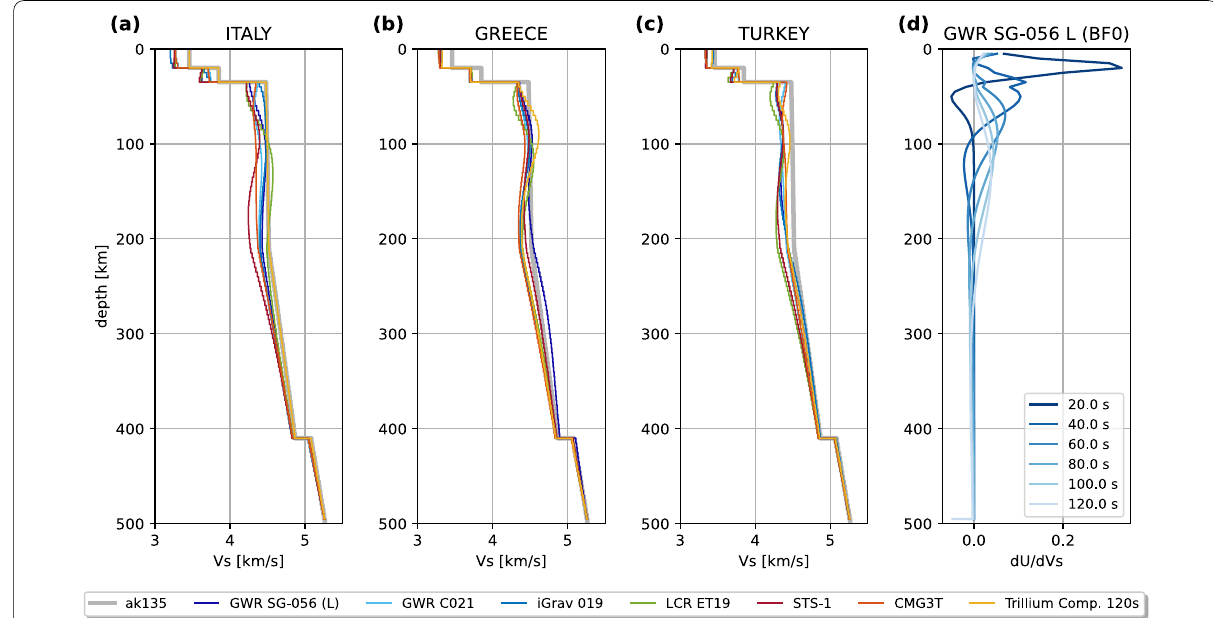
Fig. 6 Results of linear inversion method of dispersion curves of a fundamental‑mode Rayleigh wave. All inverted models together with the initial ak135 model ( a – c ). Sensitivity kernels d for SG from the Black Forest station (the Greece